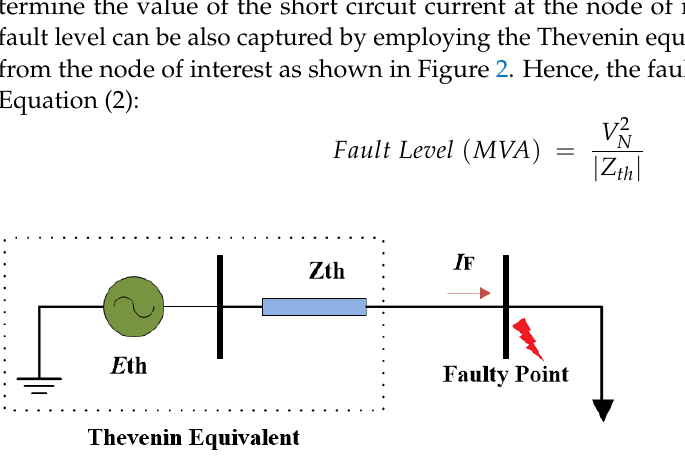
Figure 2. Thevenin equivalent of the system.